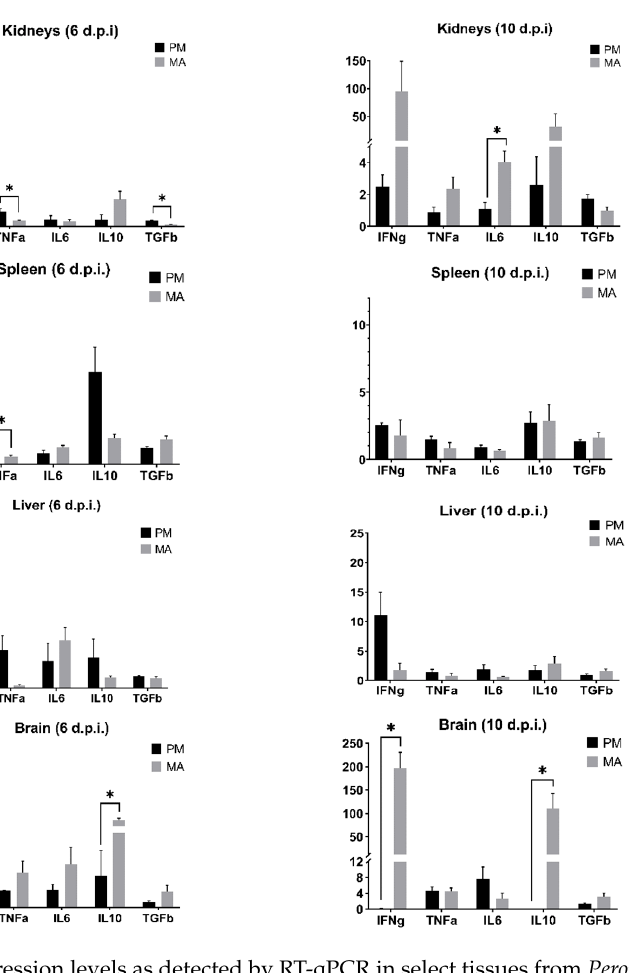
Figure 3. Cytokine gene expression levels as detected by RT-qPCR in select tissues from Peromyscus maniculatus (PM) and Mesocricetus auratus (MA). Each timepoint reflects the mean relative expression levels from infected replicates ( n = 3) of each species. Bars with asterisks (*) denote a significant difference in the expression levels between species at that collection timepoint (uncorrected for multiple tests).